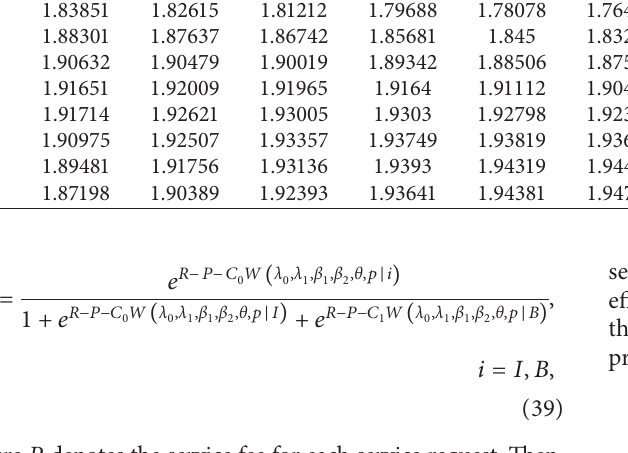
Table 2: The extended social welfare model: the expected social welfare for R � 5 ,C